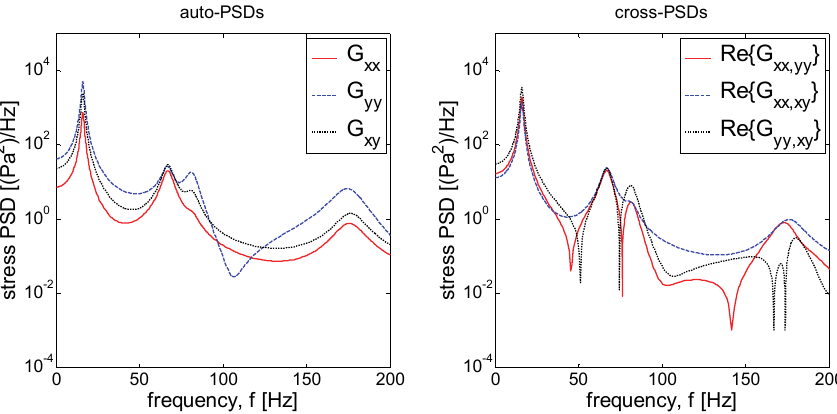
Figure 7: Auto- and cross-PSD (one-sided) in a node close to the round notch.